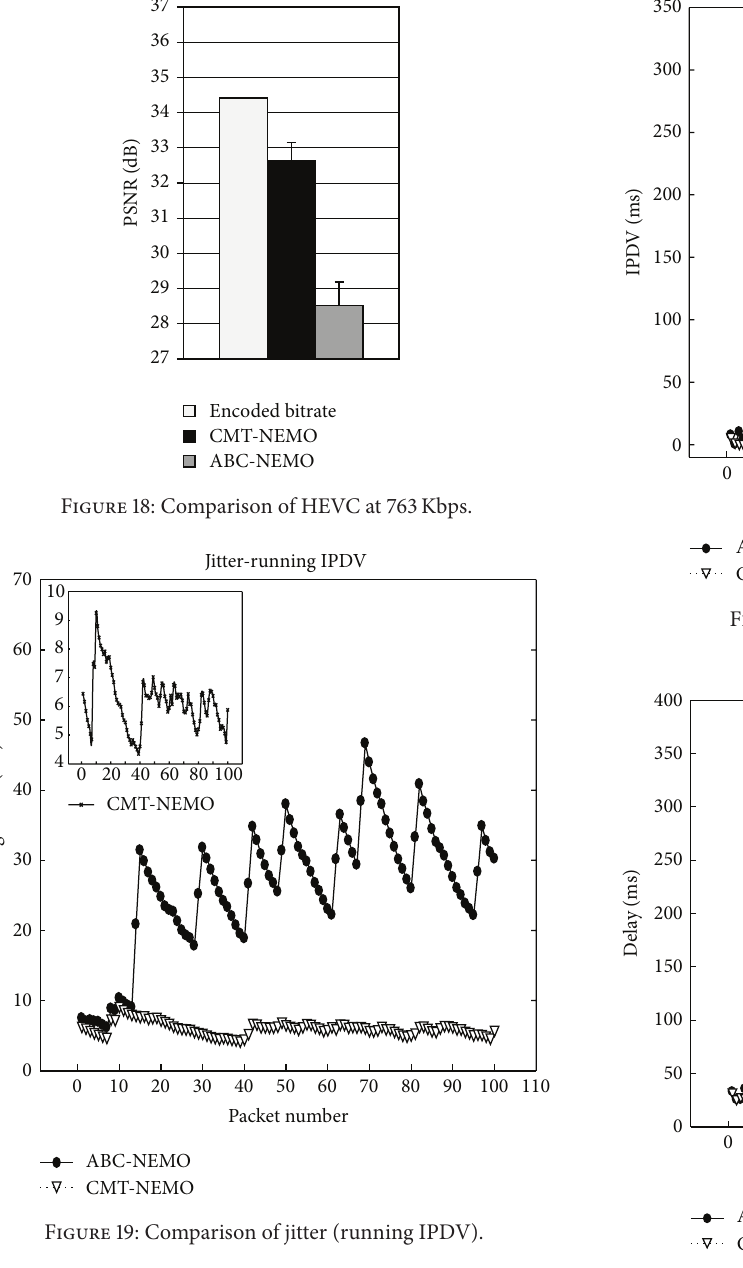
Figure 21: Comparison of end-to-end